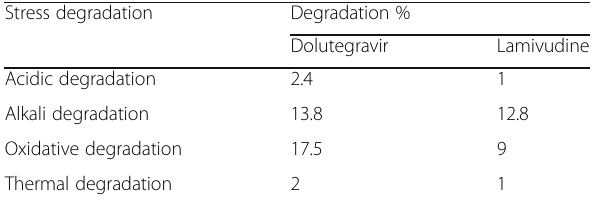
Table 7 Results of forced degradation